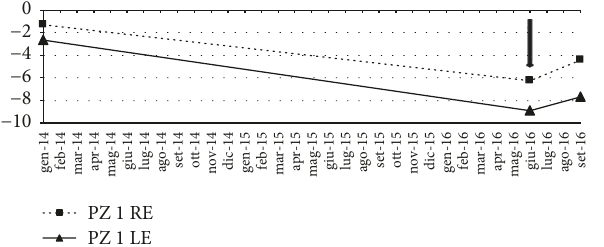
Figure 1: Patient 1. Trend of the mean deviation (MD) from January 2014 to September 2016. The arrow indicates the beginning of treatment with CBS eye drop. RE: right eye; LE: left eye.